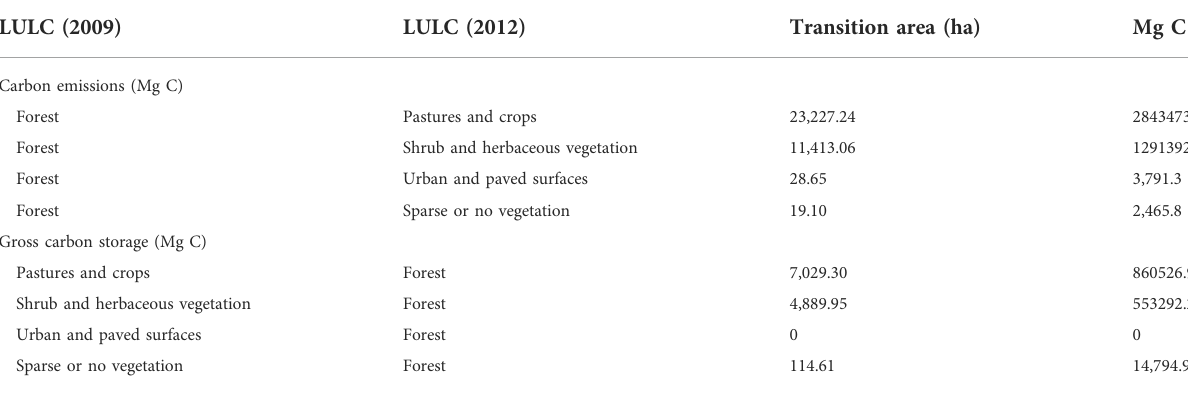
TABLE 5 Forest gross carbon emissions and gross carbon storage between 2009 and 2012 in the study